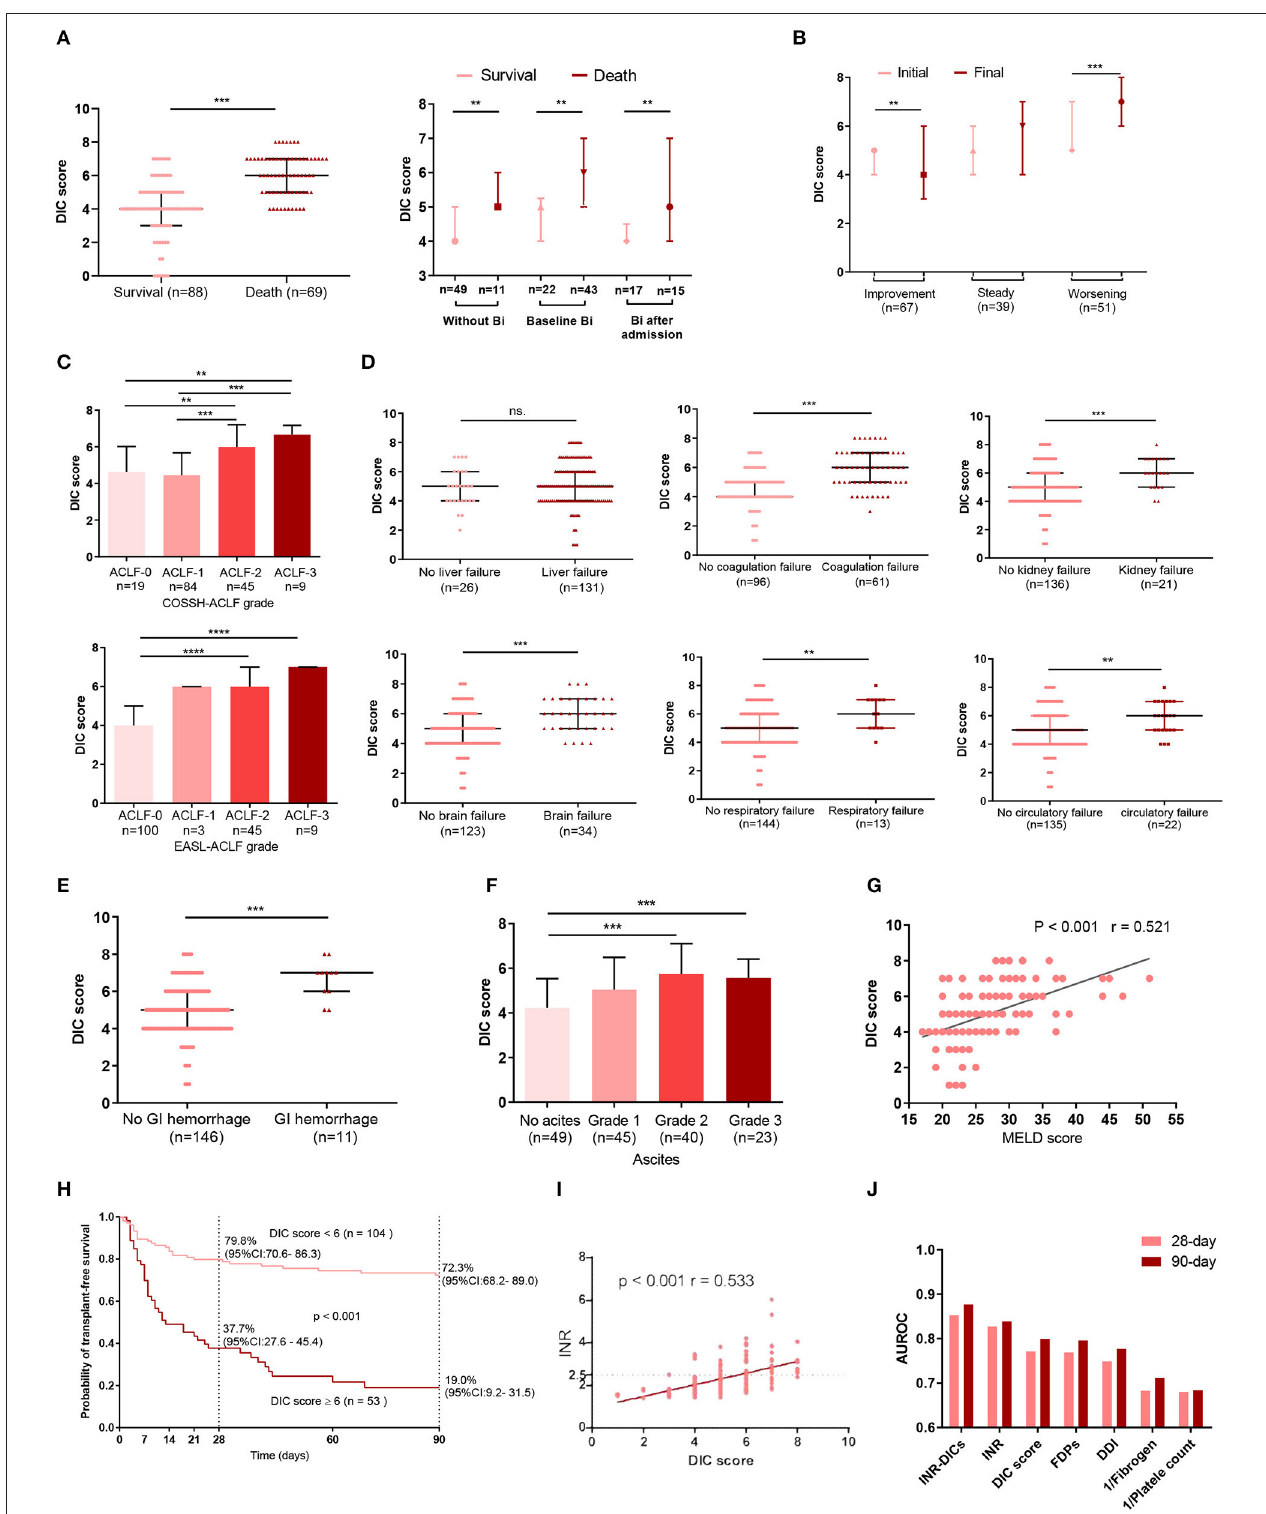
FIGURE 3 | The relationship between complications, organ failure, prognosis, INR and DIC score. (A) The DIC scores of ACLF patients with or without bacterial infection were sorted by survival states. Without Bi: patients who never had infection during the whole course within 90 days; Baseline Bi: patients who had infection at baseline; Bi after admission: patients without infection at baseline and developed bacterial infection within 90 days. (B) Dynamic changes in DIC score from initial to